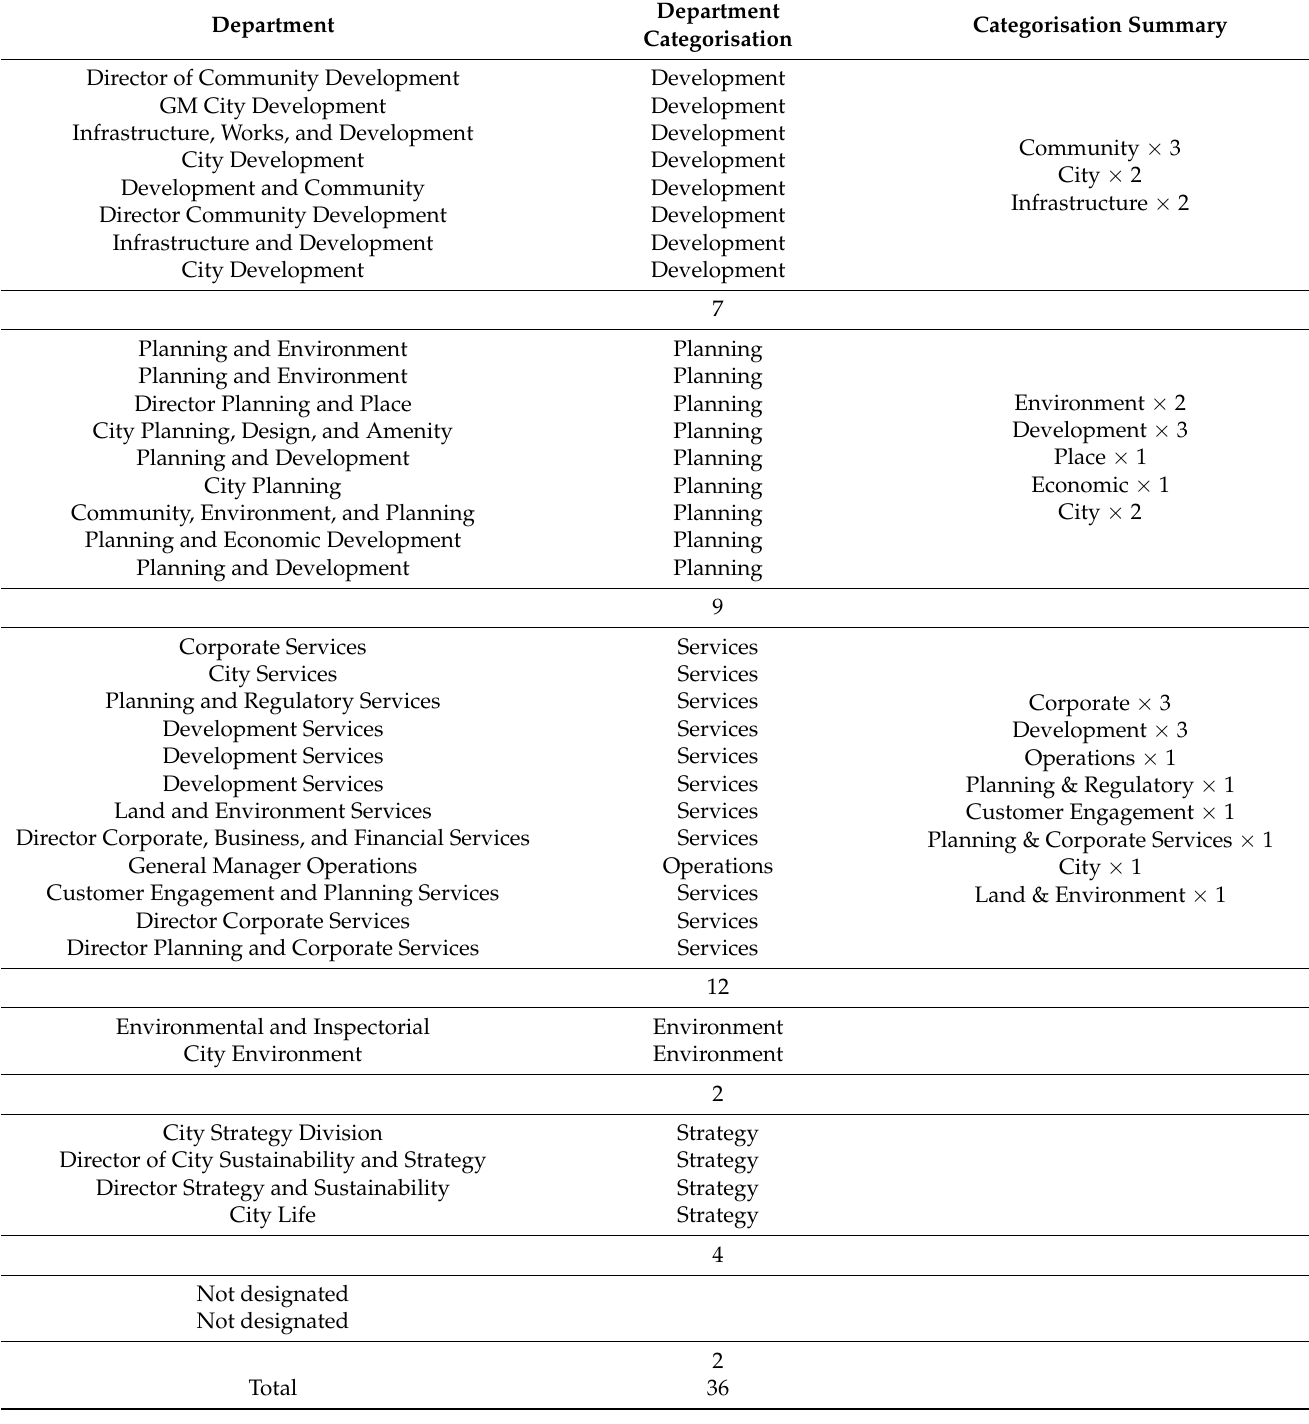
Table 1. Location of environmental health services by